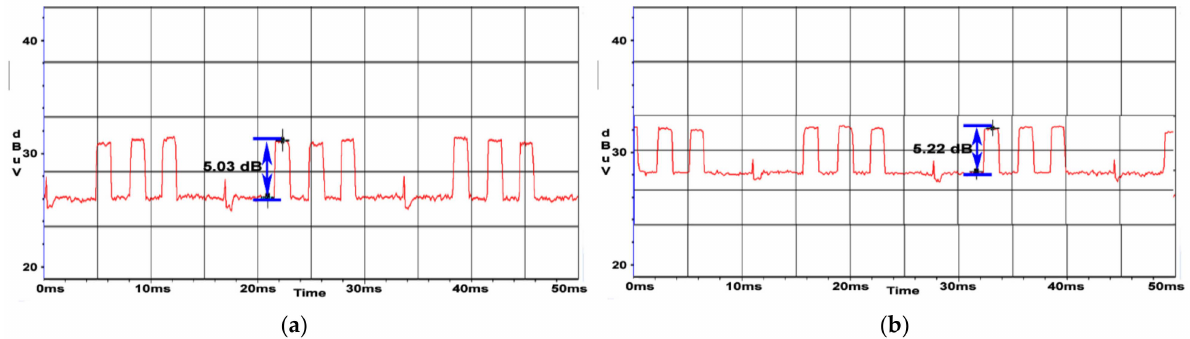
Figure 21. AOC display: ( a ) SNR measured for display’s power cable with TDK SEIWA 18 mm ferrites at both ends (SNR = 5.0 dB); ( b ) SNR measured for display’s power cable with FAIR-RITE VO 18 mm ferrites at both ends (SNR = 5.2